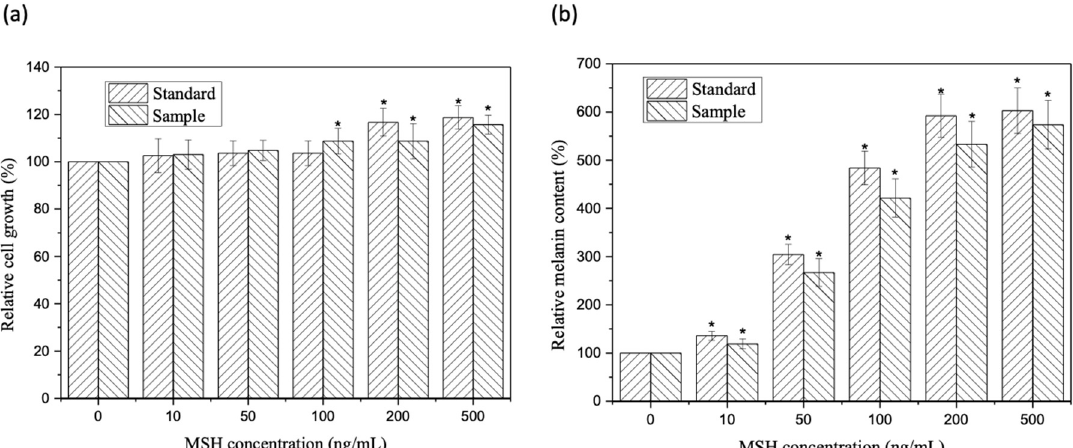
Figure 7. Cytotoxicity assay and melanin stimulation induced by pepsin-cleaved α -MSH. Cytotoxicity assay ( a ) and melanin stimulation assay ( b ) of pepsin-cleaved α -MSH (sample) in comparison with synthesized α -MSH (standard). “*” indicates the results having significant differences with reference (buffer only, MSH = 0) at p -values <0.05.